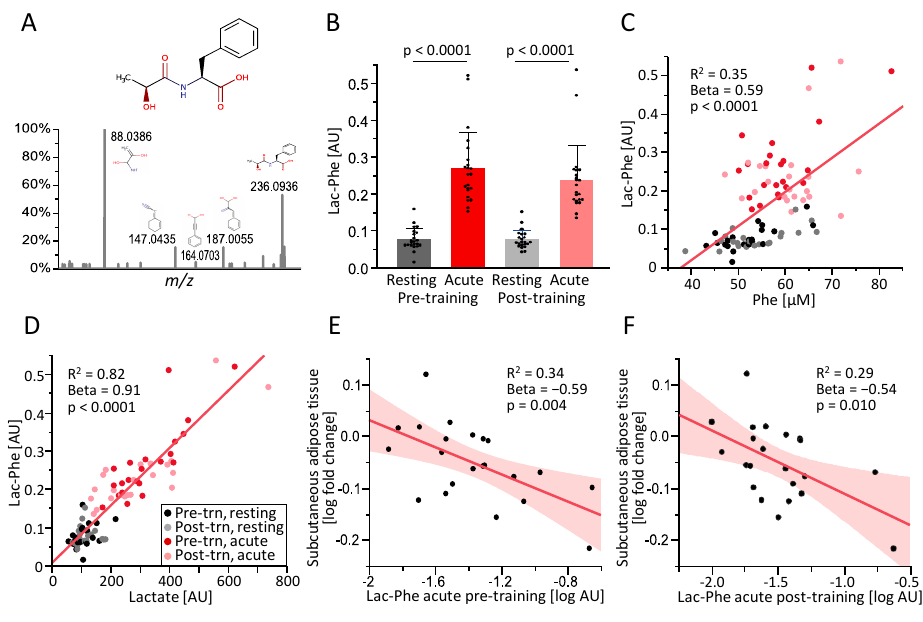
Figure 1. ( A ): Structure of N-Lactoylphenylalanine (Lac-Phe) and identification by LC-MS/MS. ( B ): Plasma levels of Lac-Phe in subjects with overweight and obesity (n = 22) before (resting) or immediately after (acute) a 30-min endurance exercise session before (pre) or after (post) an 8-week training intervention. ( C , D ): Correlation of plasma Lac-Phe with plasma phenylalanine ( C ) and lactate ( D ). ( E , F ): Correlation of the fold change in subcutaneous abdominal adipose tissue volume during the exercise intervention with the concentration of Lac-Phe after acute exercise before (pre-training, ( E ) and after the exercise intervention (post-training, ( F ). R 2 , standardized beta coefficient (Beta) and p-value are shown for the simple linear regression (values from multiple regression presented in Table 2). AU, arbitrary units.